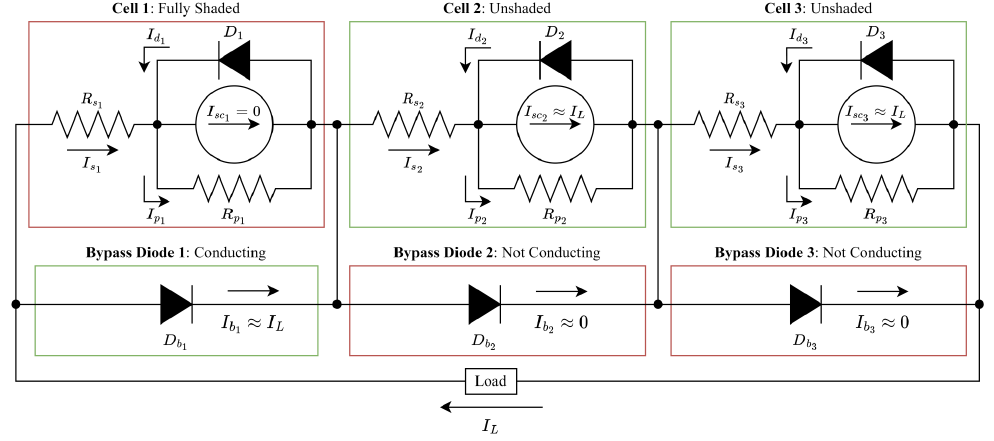
Figure 2. A demonstration of the function of bypass diodes. Three series-connected PV cells are represented by separate instances of the single diode model (SDM), and are not all subject to the same irradiance levels. Each PV cell is placed in parallel with a separate bypass diode. Developed from